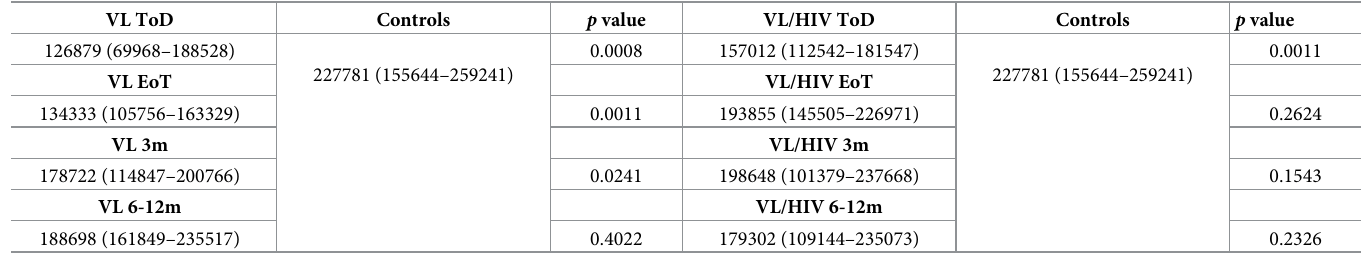
Table 6. Comparison of ROS production by neutrophils between VL and VL/HIV patients and controls over time. VL ToD